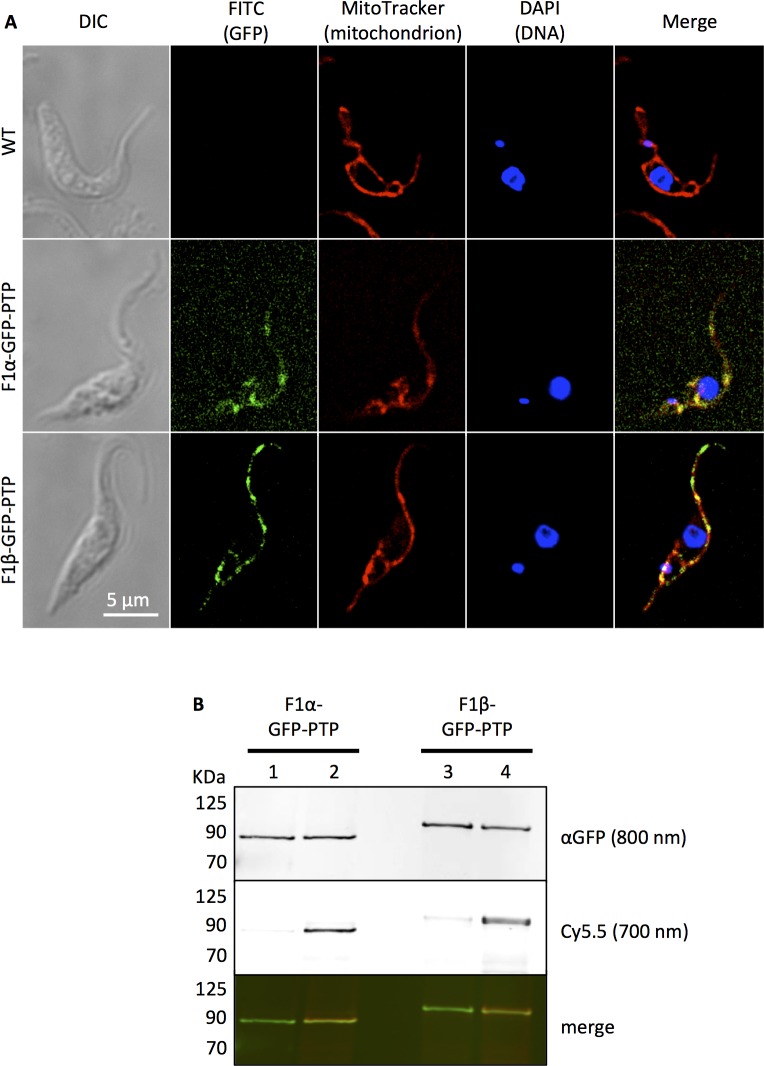
B-THP-Ts bind to C-terminal GFP-PTP tagged F1 α- and β- subunits.(A) Stably transfected PF T. brucei cells endogenously-expressing F1 α-GFP-PTP or F1 β-GFP-PTP were loaded with MitoTracker Red CMXros (red) and DAPI (blue) and imaged microscopically to determine localisation of GFP-PTP-tagged protein. F1 α-GFP-PTP and F1 β-GFP-PTP were detected through natural fluorescence of their green fluorescent protein (GFP) tag, and both were found to co-localise with MitoTracker, confirming their mitochondrial association. (B) Following in vivo photo-affinity labelling with 50 μM compound 3 or compound 1 (negative control), GFP-PTP-tagged F1 α- and β-subunits were affinity purified and Cy5.5 clicked on. Proteins were separated by SDS-PAGE and a western blot was performed with mouse anti-GFP / anti-mouse-DyLight 800. GFP-PTP-tagged proteins were revealed at 800 nm, Cy5.5-bound target proteins at 700 nm, and a merged image shows both together. Lanes 1 and 2 used compounds 1 and 3 respectively with F1 α-GFP-PTP-expressing cells and captured F1 α-GFP-PTP migrating at 89 KDa was observed with anti-GFP at 800 nm in both lanes. F1 α-GFP-PTP only fluoresced at 700 nm when bi-functional compound 3 was used, indicating that Cy5.5 had bound specifically to the F1 α-subunit via our bi-functional photo-affinity probe. Lanes 3 and 4 used compounds 1 and 3 respectively with F1 β-GFP-PTP-expressing cells, and captured F1 β-GFP-PTP migrating at ~101 KDa was observed in both lanes with anti-GFP. As with the α-subunit, β-GFP-PTP only conjugated Cy5.5 when the bi-functional compound 3 was used, confirming that both the α- and β-subunits are targets of our B-THP-T compounds.